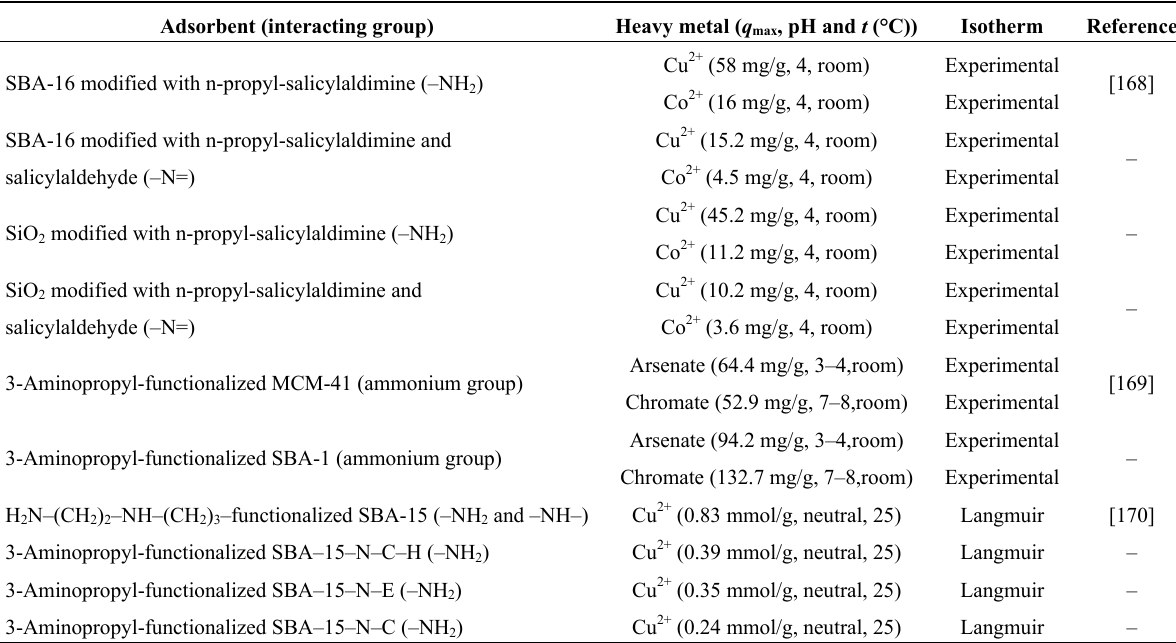
Table 2. Adsorbed heavy metals, maximum adsorption capacity, pH and temperature for adsorption of heavy metals by mesoporous